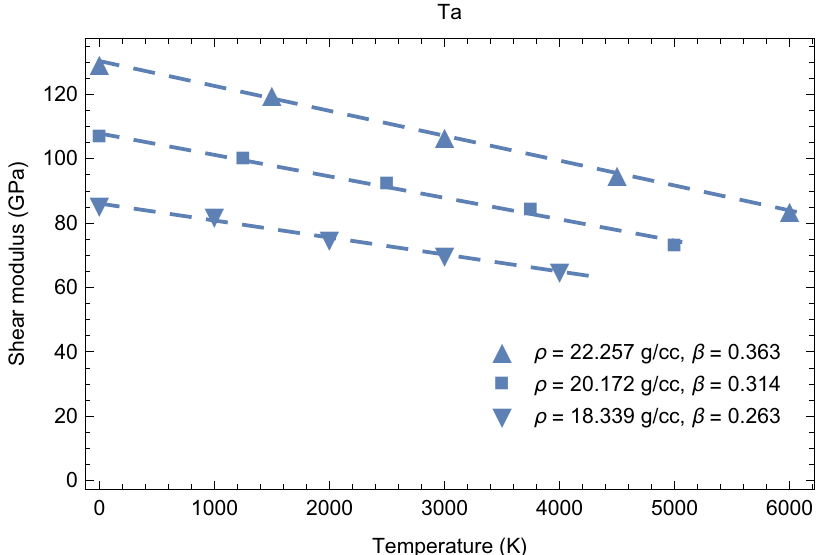
Figure A1. The shear modulus of bcc-Ta as a function of T at three different densities.